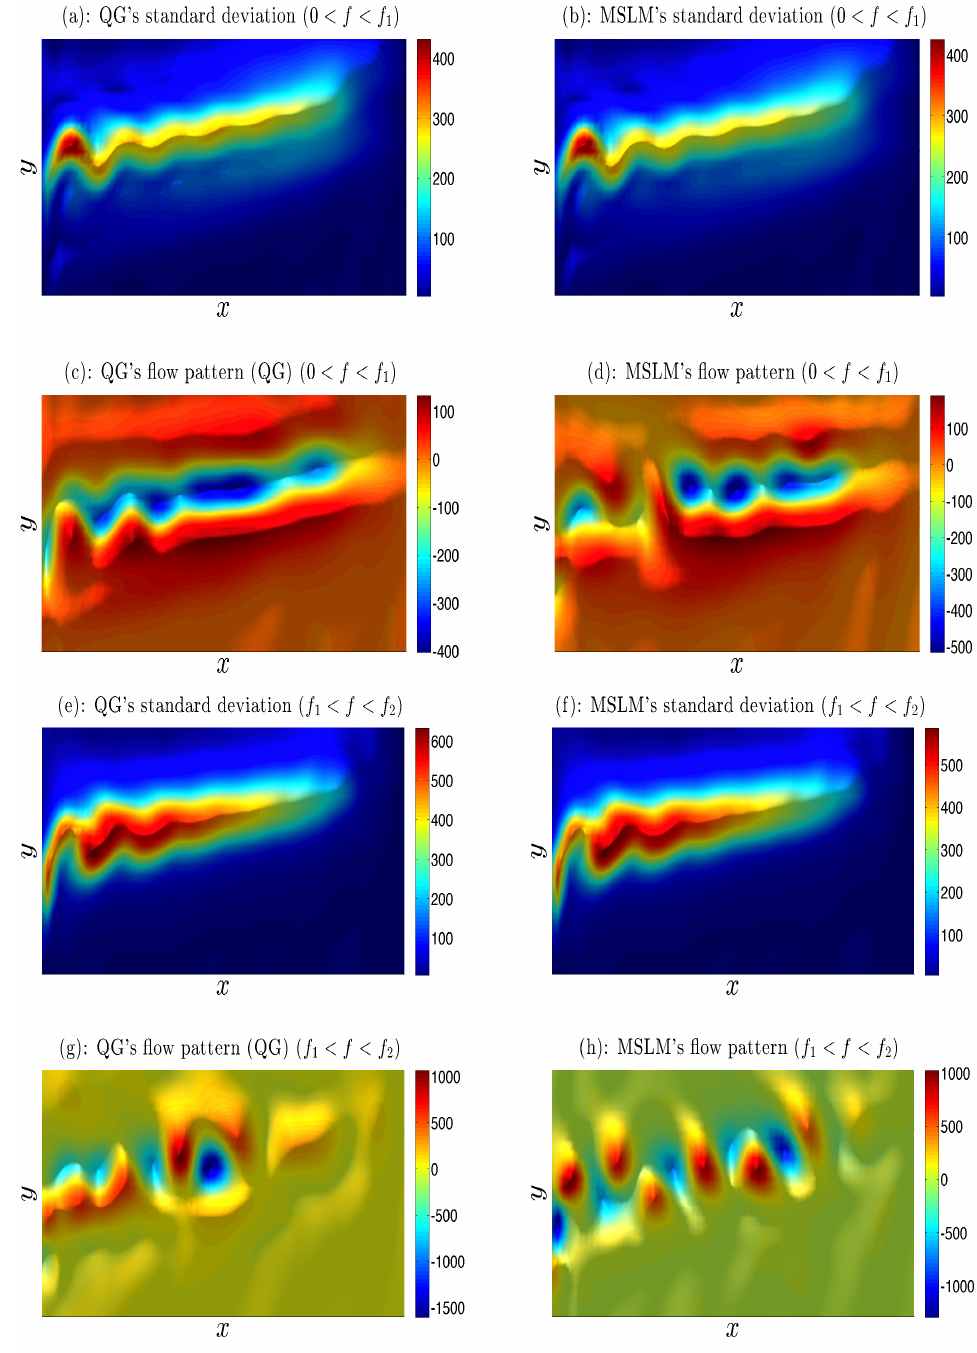
Figure 8. Upper-level stream function anomalies and standard deviation: QG vs. MSLM. The QG’s standard deviation (SD) and its MSLM emulation are shown here in Panels ( a , b ), respectively, for the low-frequency range 0 < f < f 1 = 0.18 y − 1 . Panels ( c , d ) depict typical flow patterns underlying the SD patterns for the QG model and MSLM, respectively. Panels ( e , f ) (resp. ( g , h )): same as for Panels ( a , b ) (resp. ( c , d )), but for the intermediate frequency range f 1 = 0.18 y − 1 < f < f 2 = 5.27 y − 1